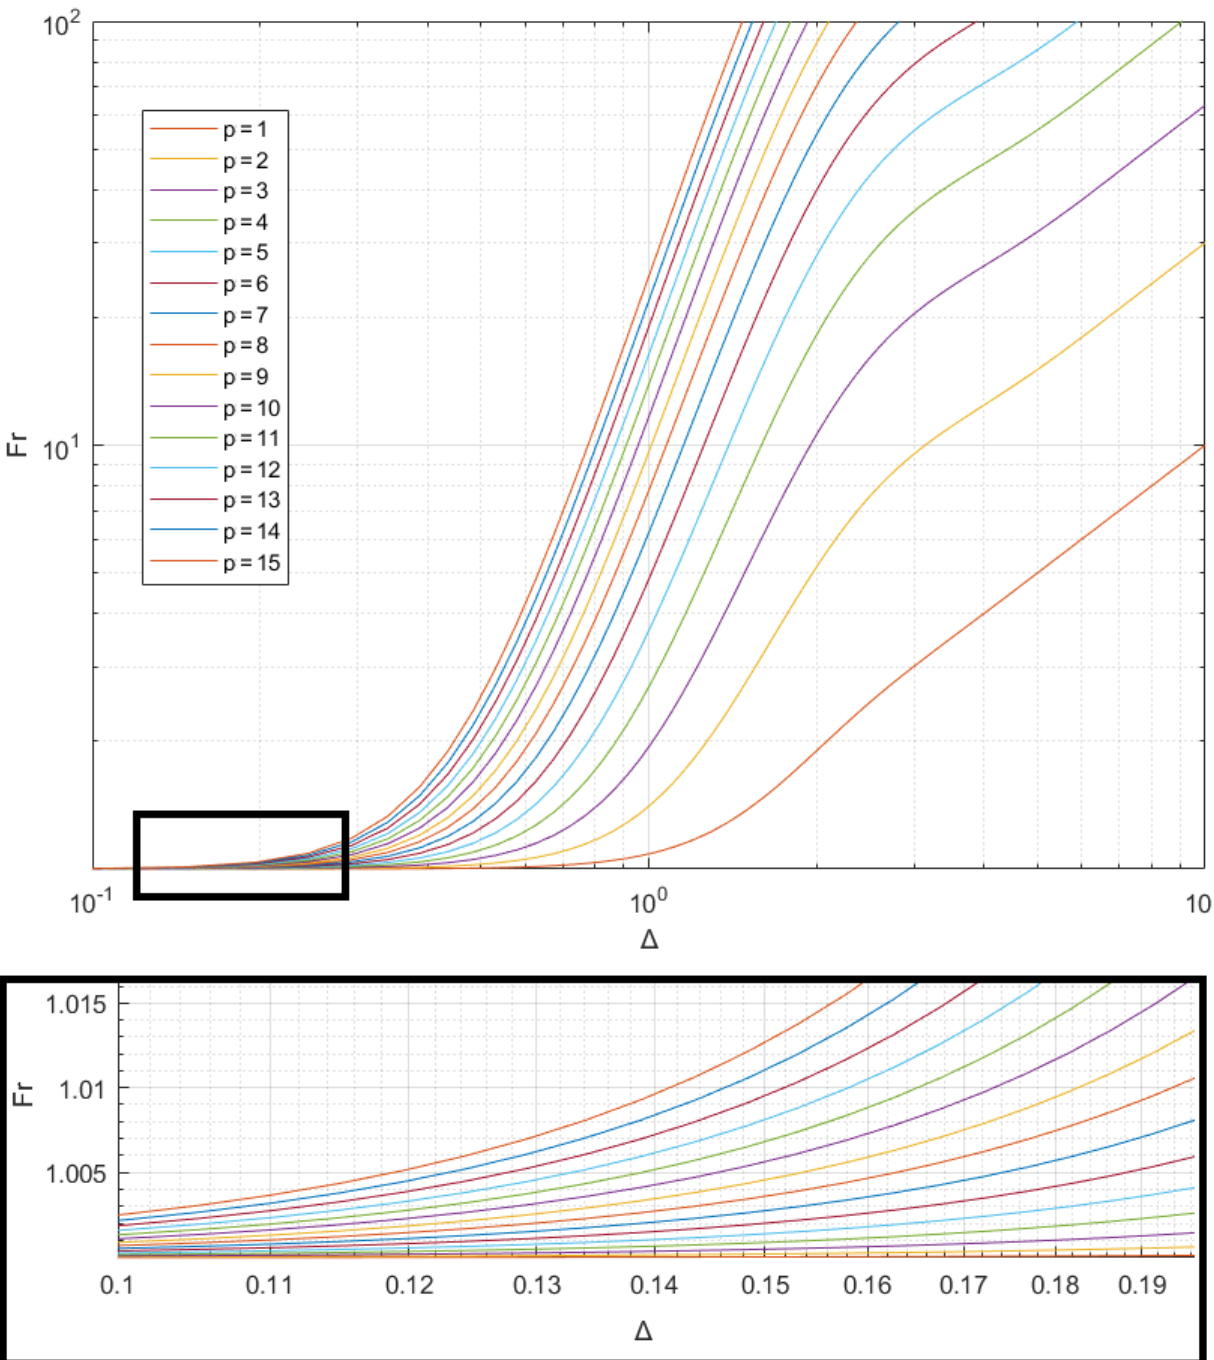
Figure 7. The ratio of AC resistance to DC resistance as a function of ∆ and MMF ratio p .